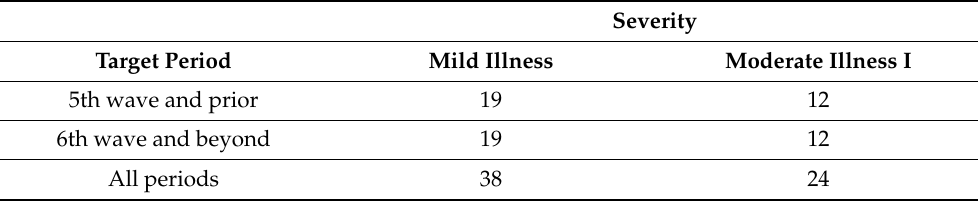
Table 7. The amount of subject data used for